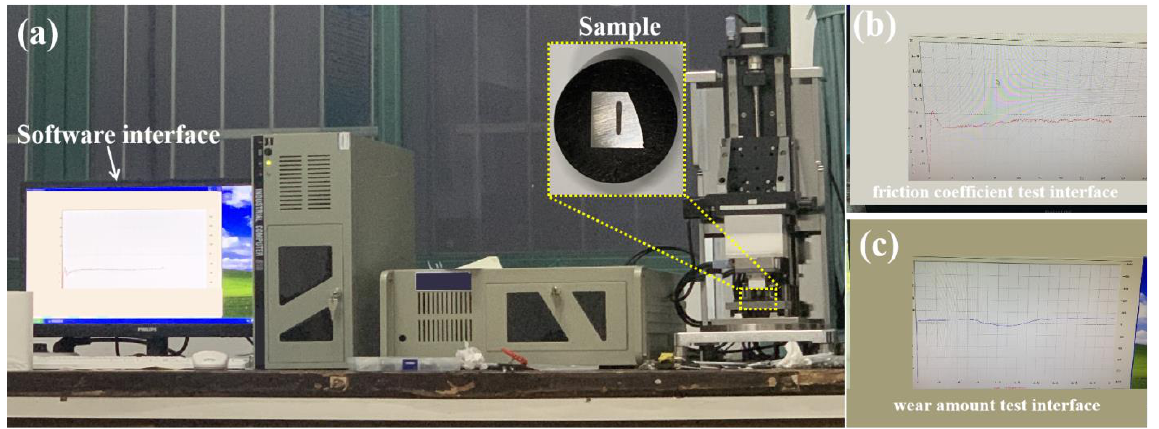
Figure 3. ( a ) CFT-1 comprehensive material surface property tester, ( b ) friction coefficient test interface, and ( c ) wear amount test interface.